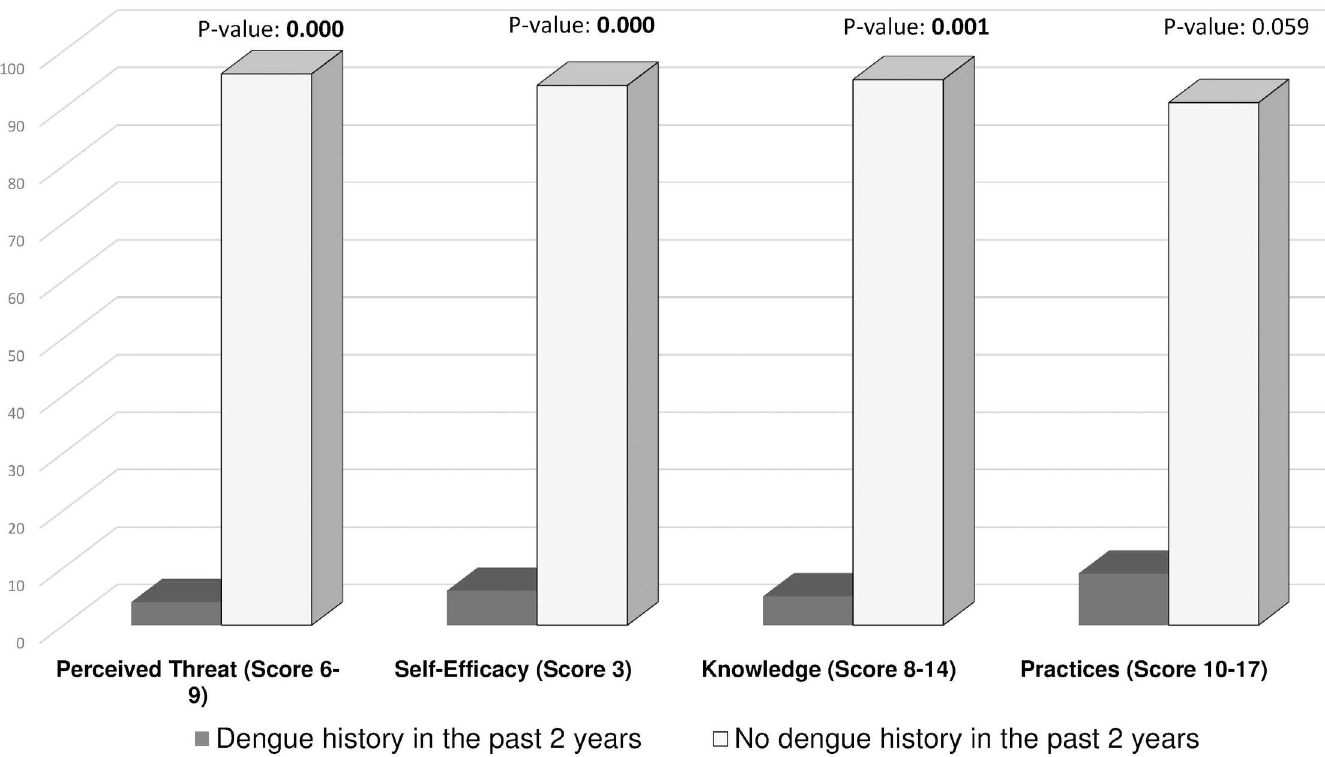
Fig 1. History of Dengue Fever in the Past 2 Years and Its Association with Dengue Knowledge, Practices, and Health Beliefs. Bars represent percentages of respondents with high perceivedthreat of dengue,self-efficacy, adequatedengueknowledge,and preventivepractices scores according to the history of denguefever in the past 2 years. P-values shown in bold indicate a significant association.